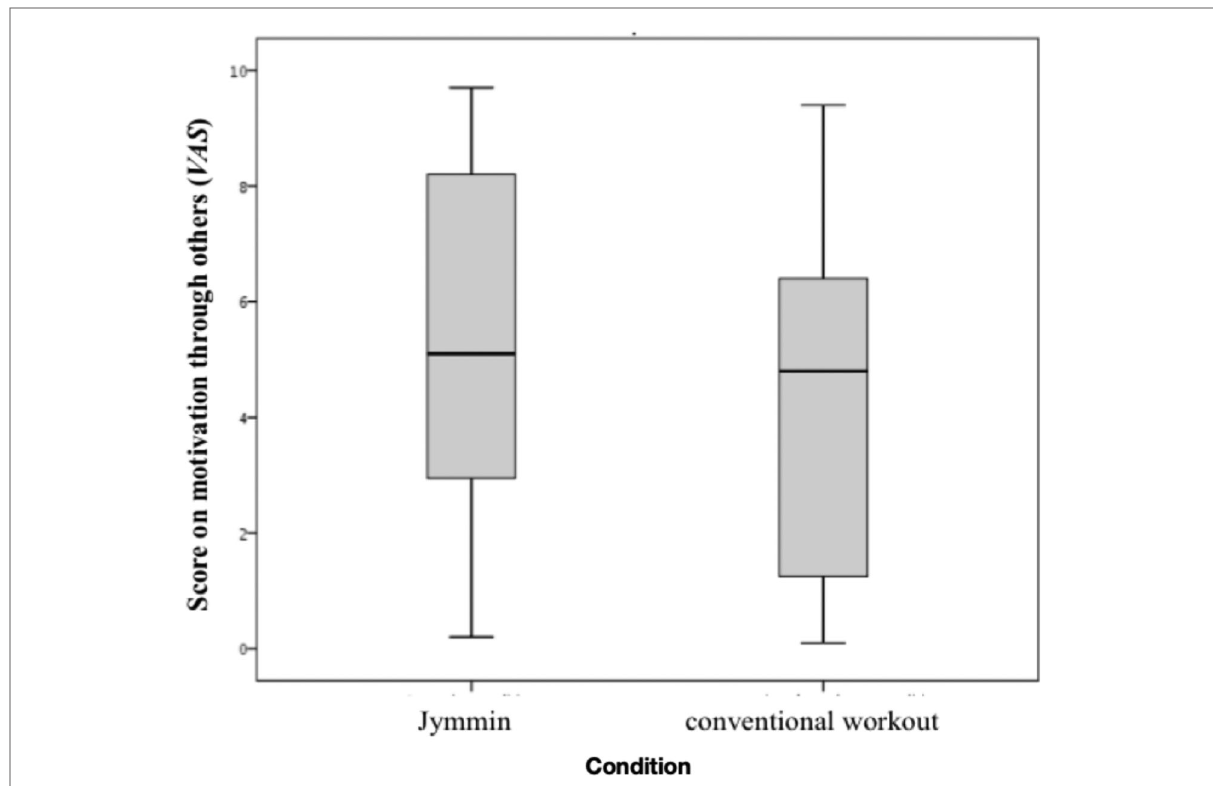
FIGURE 5 The fi gure depicts scores on the motivation through others during the Jymmin or conventional workout condition as measured on a VAS . AWilcoxon Signed Rank Test revealed signi fi cant difference between medians of the Jymmin and conventional workout condition. The motivation through other training partners was signi fi cantly higher during Jymmin as compared to conventional workout